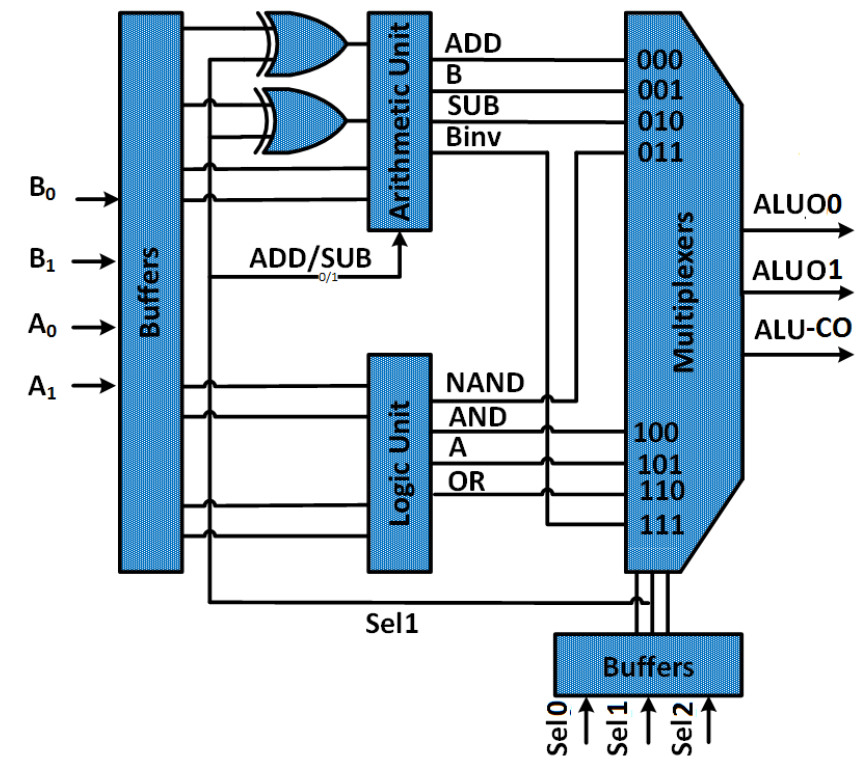
Figure 17. 2-Bit ALU block diagram consisting of an arithmetic unit that performs addition and subtraction based on ADD/SUB signal connected to Sel1. The logic unit perform bitwise AND, OR, NAND, and Invert operations. The select lines Sel1, Sel2, and Sel3 are used to select among different